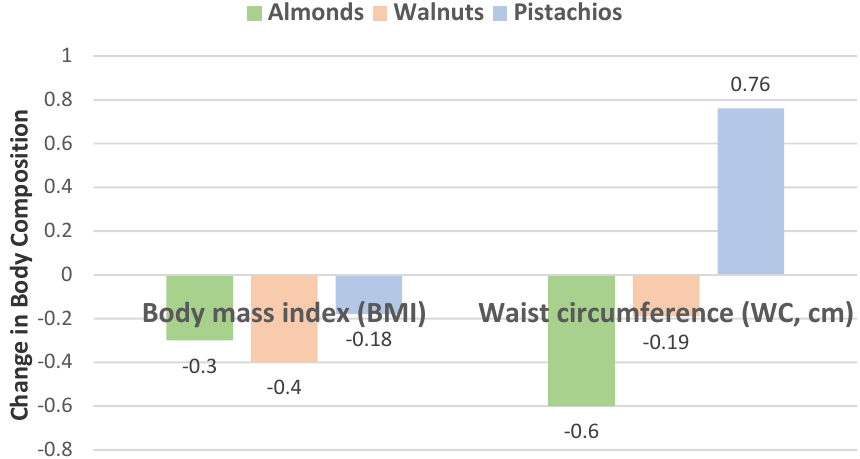
Figure 2. ( A ) Effect of nut-enriched diets compared to control diets on mean changes in body and fat mass (almonds body mass p = 0.007 and fat mass p ≤ 0.001; walnuts body mass p = 0.193 and body fat p = 0.476; pistachios body mass p = 0.141) [25–27]. ( B ) Effect of nut-enriched diets compared to control diets on mean changes in BMI (almonds p = 0.10, walnuts p = 0.164, and pistachios p < 0.001) and waist circumference (WC) (almonds p = 0.078, walnuts p = 0.651, and pistachios p = 0.087) [25–27].